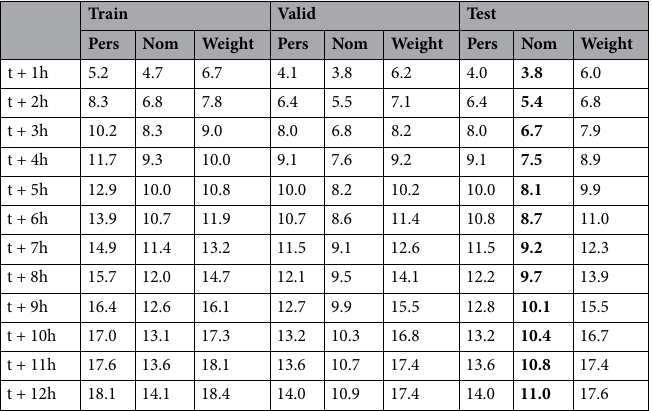
Table 2. Root Mean Square Error [nT] in train, validation, and test for the three models: persistence, nominal, weighted. The nominal has better performance in the test set, but this is connected with the dataset being highly unbalanced towards Dst values > − 20 nT. Best results are in